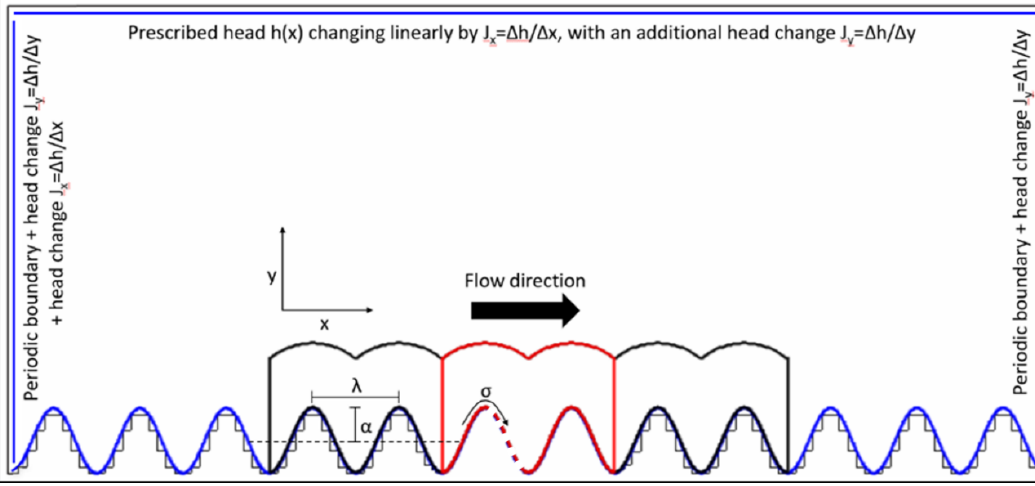
Figure 1. Overview of the finite-element model domain, with all boundary conditions labeled. The near-stream area outlined in black, encompassing the smaller area outlined in red, is the full extent of the vegetated riparian area, simulated with MODFLOW’s EVT boundary condition. The area outlined in red is the area of interest pictured in proceeding figures. The dashed red line corresponds to the segment of the stream–aquifer interface along which MODPATH particles were released. Blue lines correspond to constant head (CHD) boundaries.